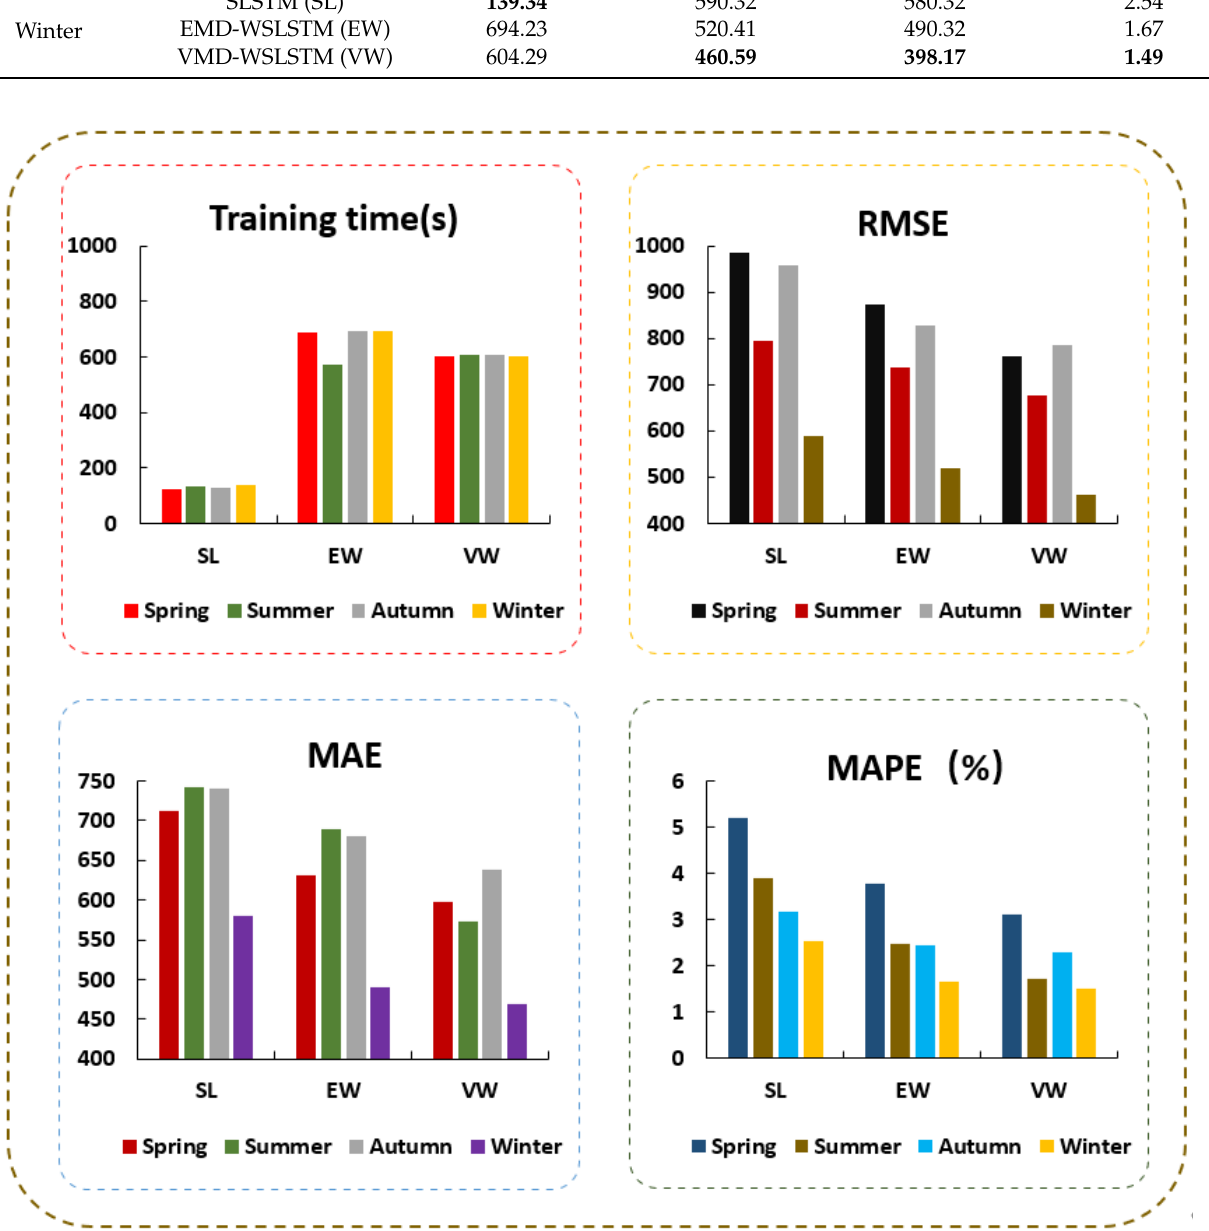
Figure 8. Prediction results of different decomposition methods.